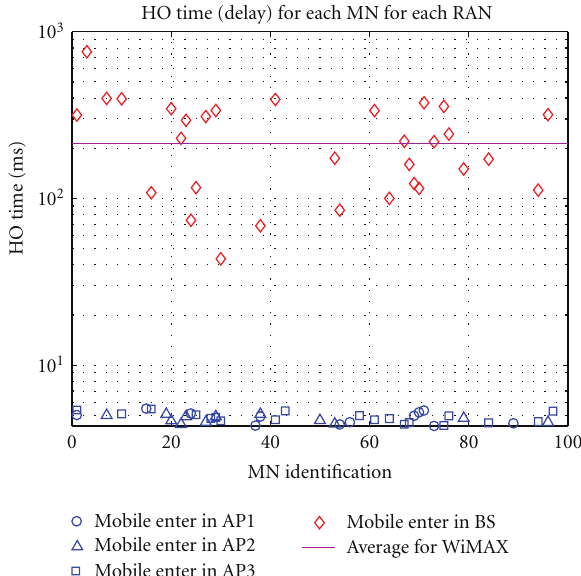
Figure 12: HO time for each MN (total of 100 MNs in topology).